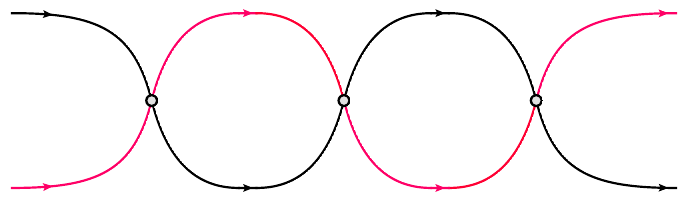
XZ ¯ X ¯ Z in the large- N A